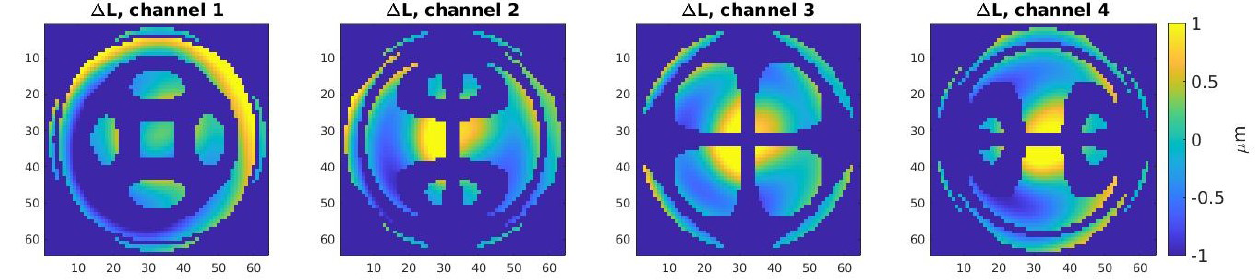
Figure 4. An example of the calculated differences of optical path length differences for one specimen (cid:49)L , with an asphere as the underlying design topography. The four different images originated from the disjointed sets of wave fronts that resulted from the four different mask settings at the 2D point source array.